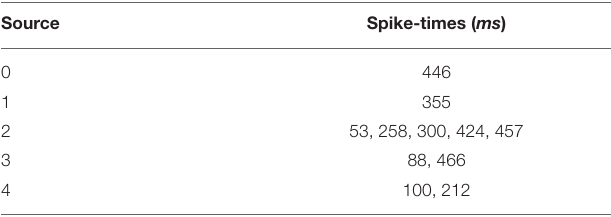
TABLE 2 | External spike-time values.